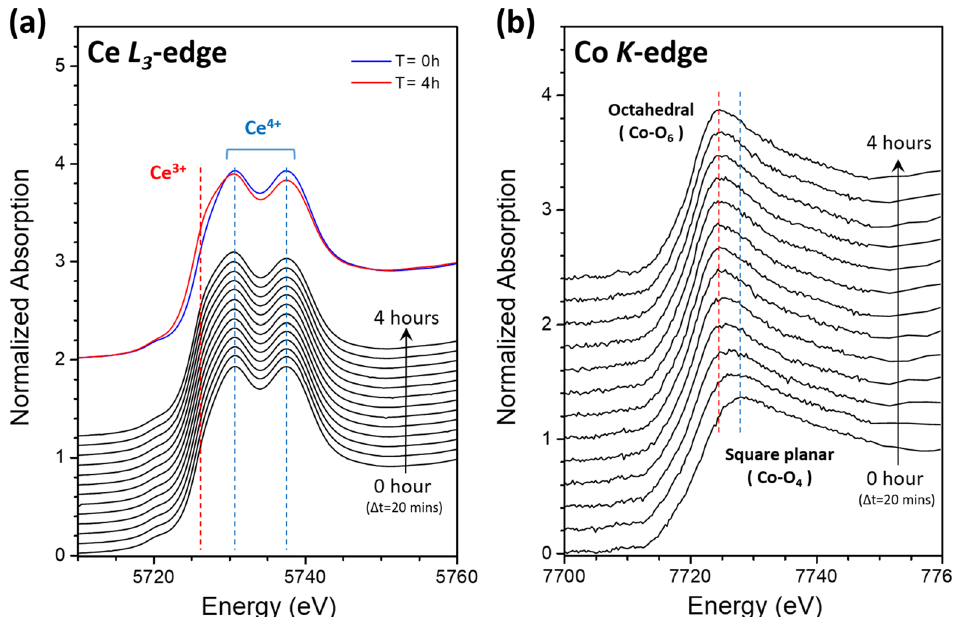
Figure 3. ( a ) Ce L 3 -edge and ( b ) Co K-edge XANES data for annealed (Y, Co) codoped doped CeO 2 sample with different irradiation time. Δ t is the increment of irradiation time.